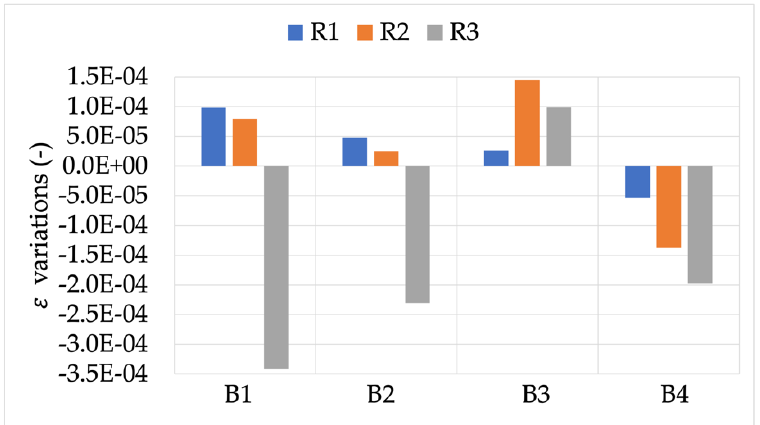
Figure 3. 𝜀 variations, when measuring signal X, for burdens B1 to B4.